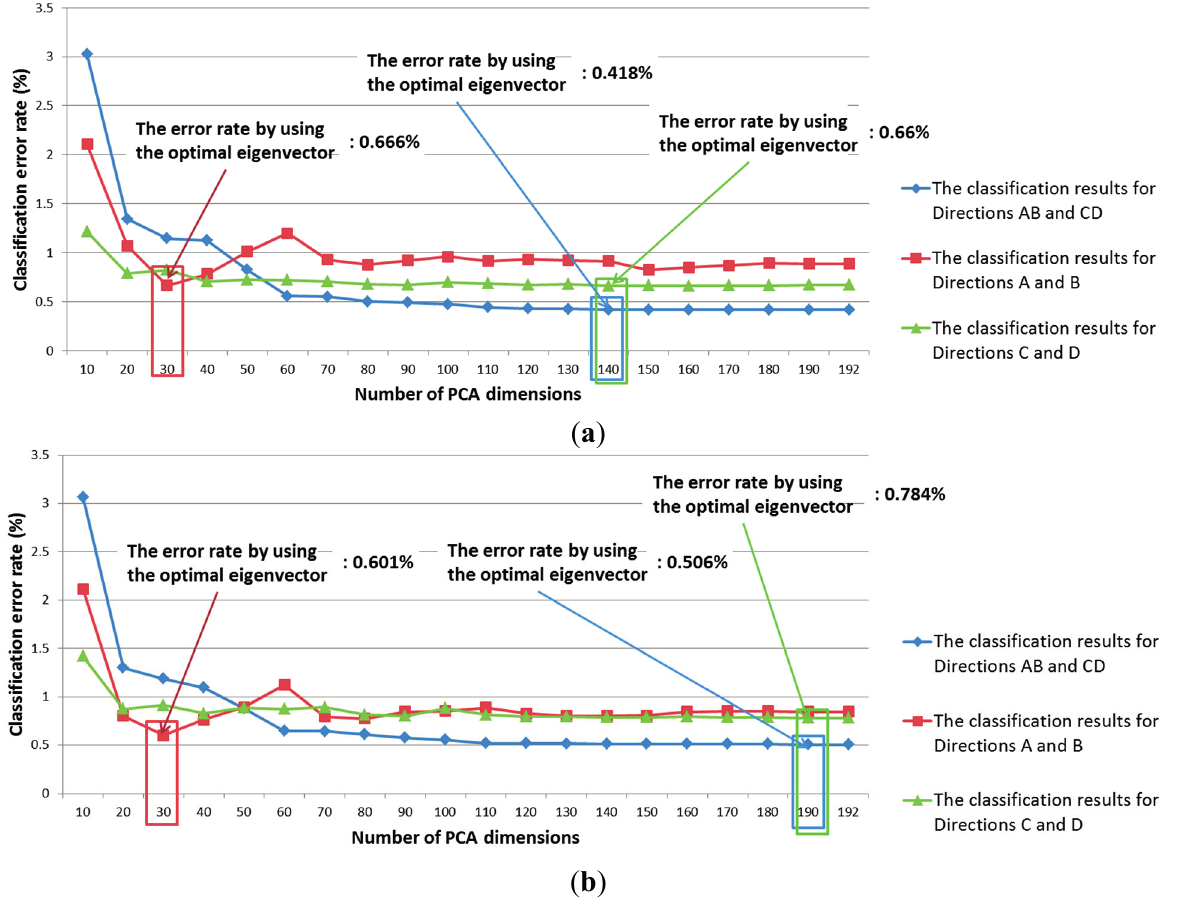
Figure 5. Classification accuracy of PCA according to number of PCA dimensions: ( a ) Group 1; ( b ) Group 2.